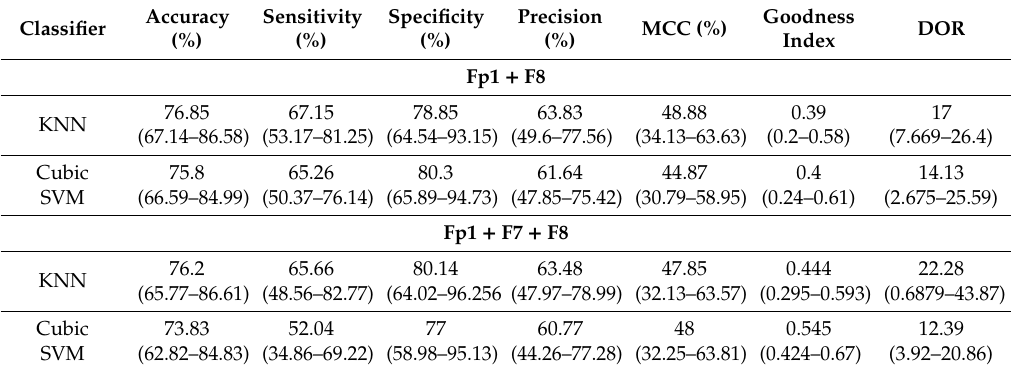
Table 11. Performance metrics for predicting stress levels with Fp1 + F8 and Fp1 + F7 + F8 electrodes using leave-subjects-out cross